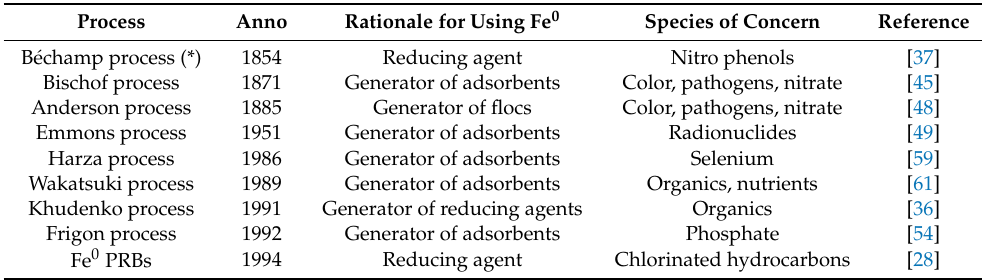
Table 1. Chronological overview of processes relevant for the discussion of the mechanism of contaminant removal in Fe 0 / H 2 O